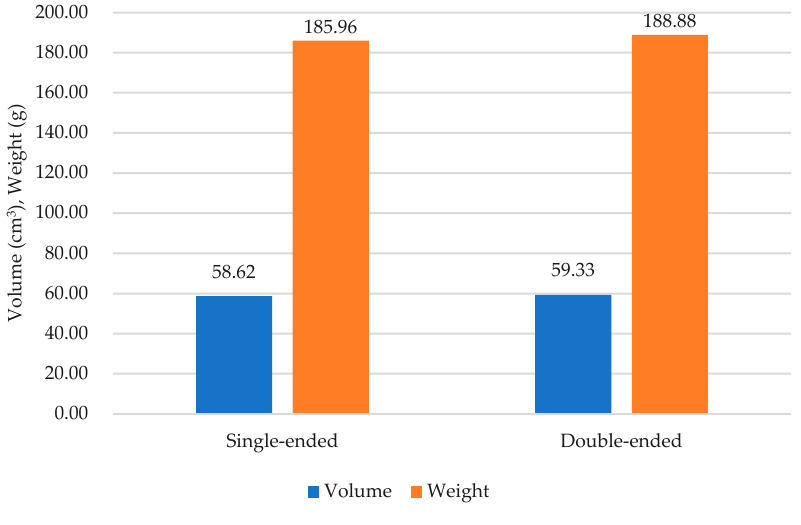
Figure 16. Comparison of volume and weight.